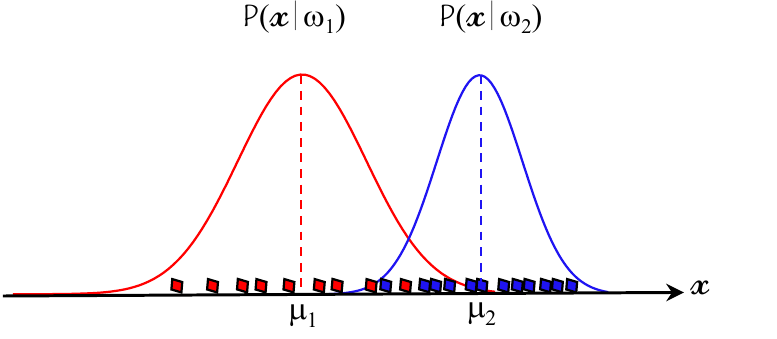
Figure 10. Class-conditional probability distributions of features. Algorithm 1: Naïve Bayes (NB) classification